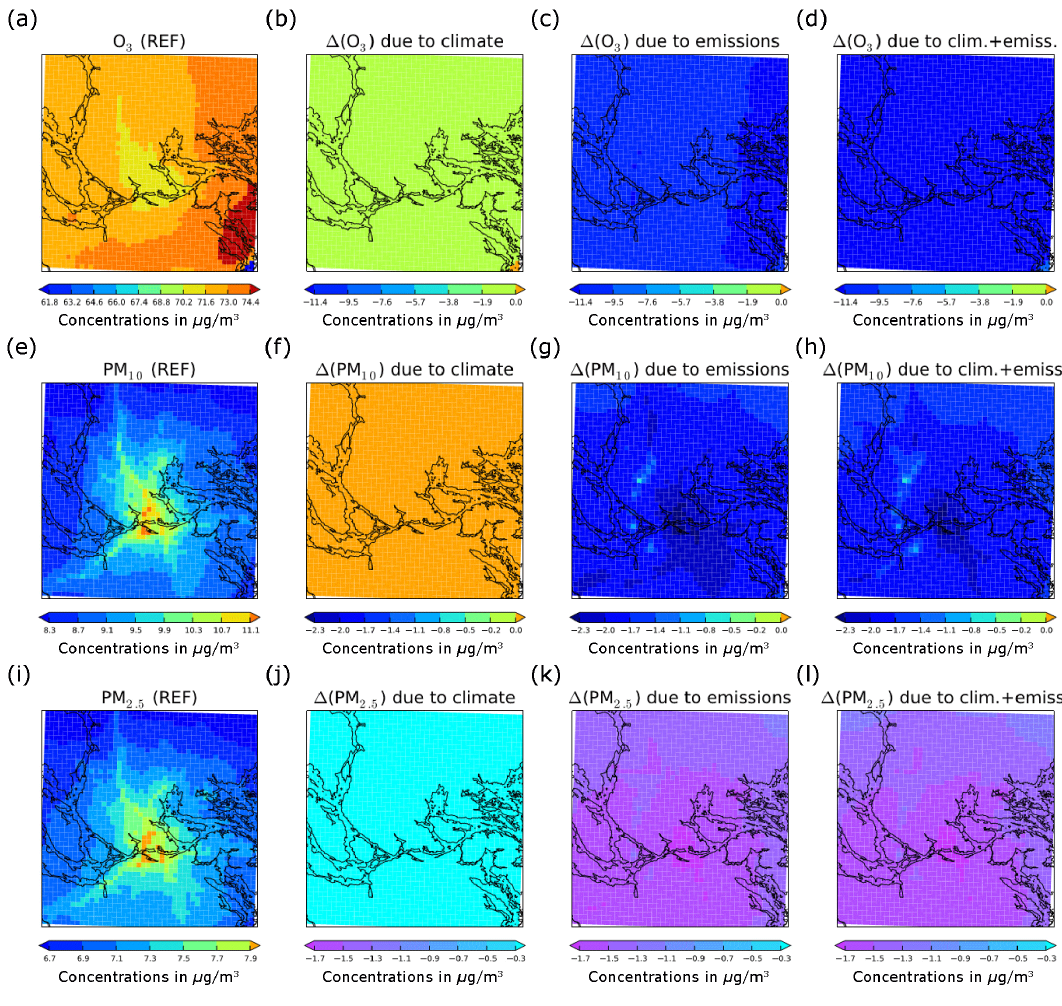
Figure 5. Similar to Fig. 4 for